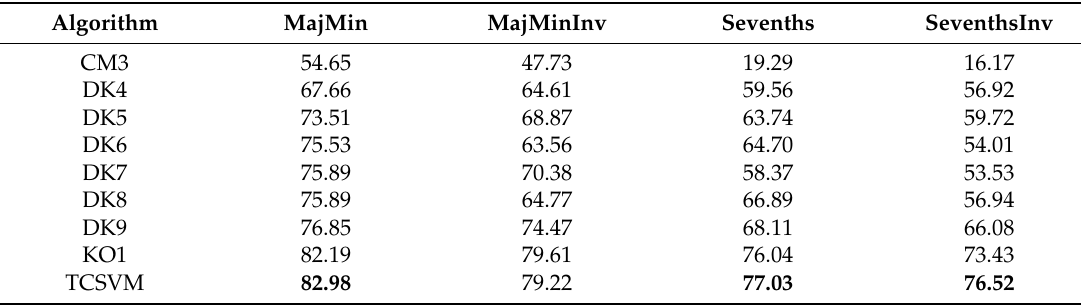
Table 1. Comparison of recognition rates of the 2015 edition on Isophonics 2009